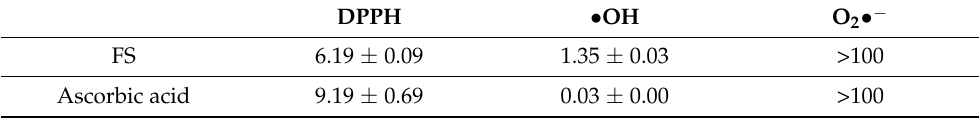
Table 1. In vitro free radical scavenging activities of N -feruloyl serotonin in IC 50 value ( µ